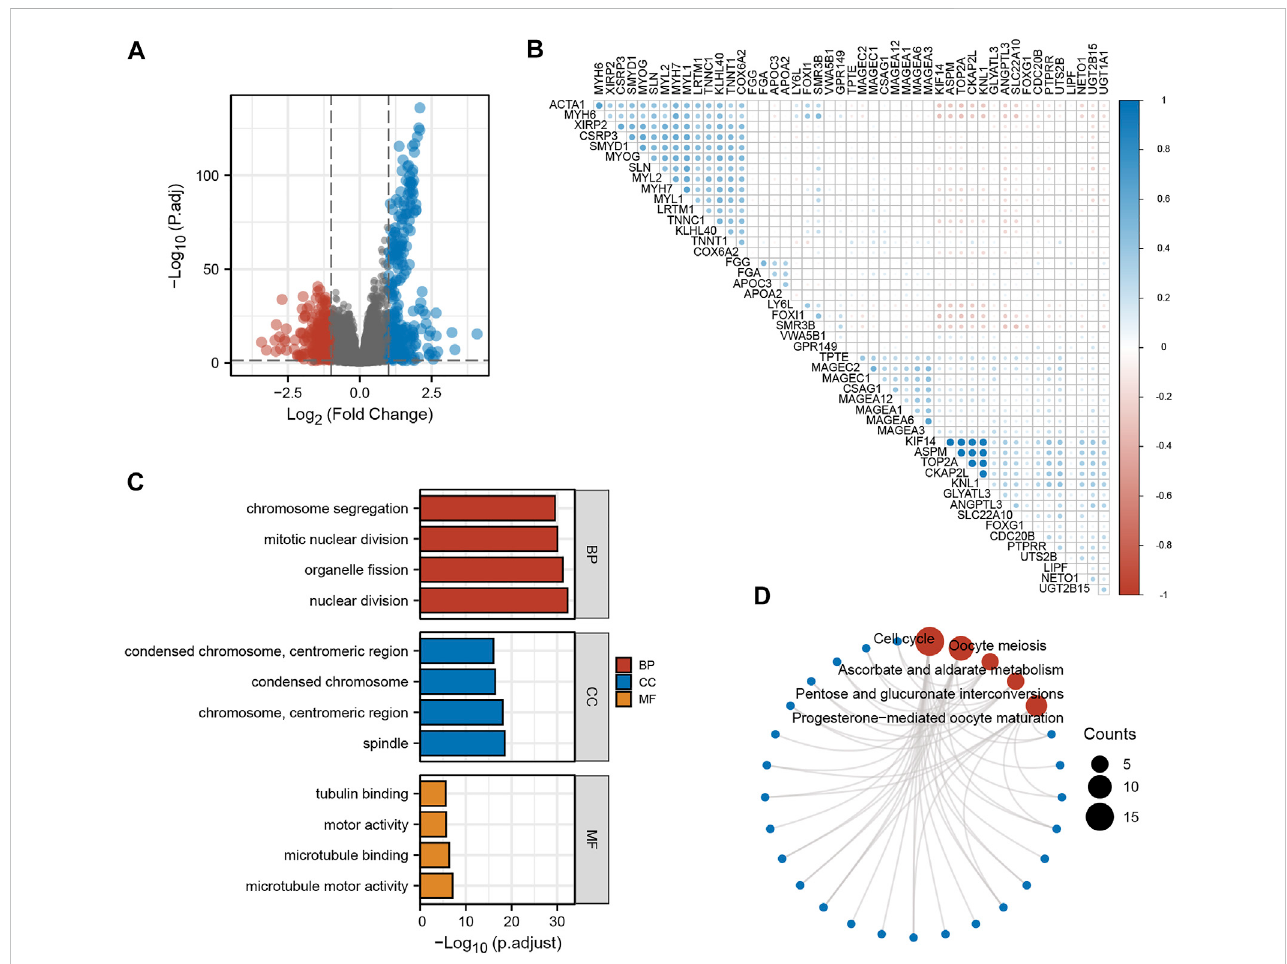
FIGURE 5 Screeningandfunctionalenrichmentanalysisofrelatedgenes. (A) Volcanoplotforsingle-genedifferenceanalysis(|LogFC| > 1,p.adj < .05). (B) Correlation Heatmap for Single Gene Difference Analysis (|LogFC| > 2, p. adj < .01). GO (C) and KEGG (D) analysis of 300 genes positively correlated with